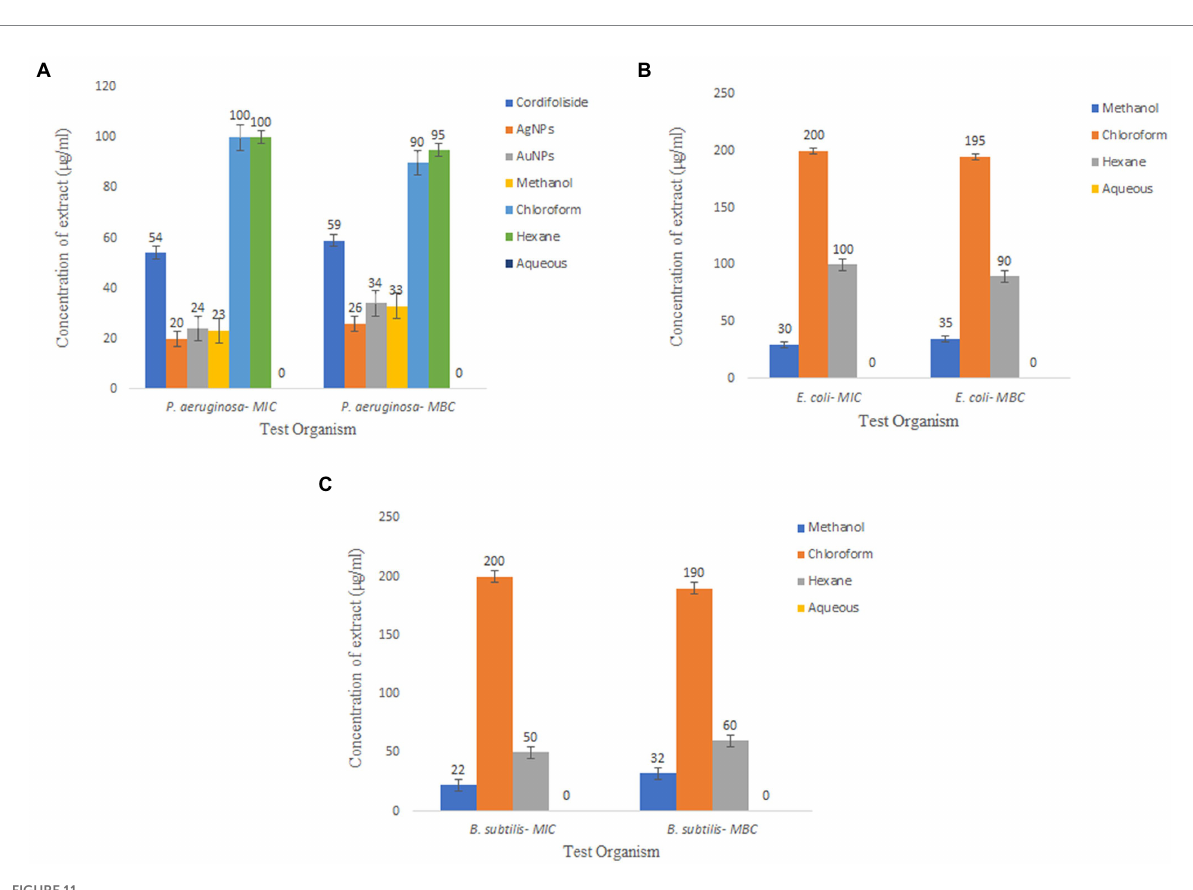
FIGURE 11 Minimum Inhibitory Concentration and Minimum Bactericidal Concentration of T. cordifolia extracts tested against (A) P. aeruginosa, (B) E. coli, (C) B.